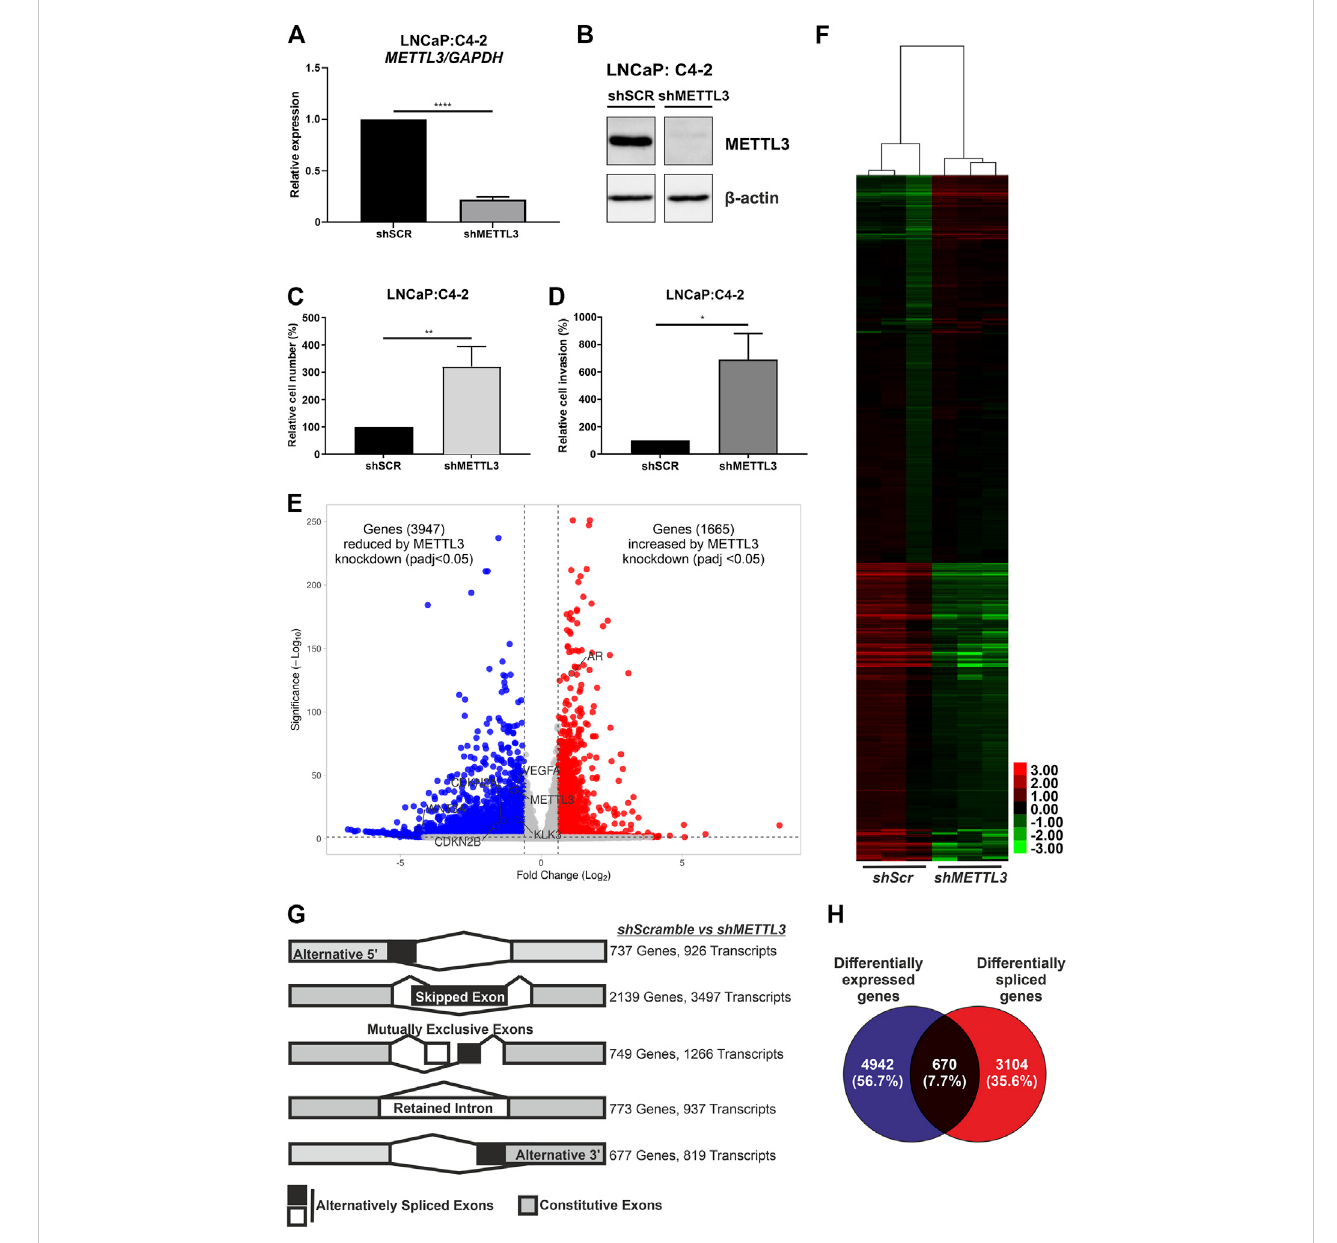
FIGURE 6 Inducible shRNA-mediated knockdown of METTL3 in LNCaP:C4-2 cells. Con fi rmation of METTL3 knockdown in LNCaP:C4-2 cells at the RNA (A) and protein (B) level. Cellular proliferation (C) and invasion (D) in sh METTL3 -treated LNCaP:C4-2 cells compared with shSCR scrambled controls. Distribution of differentially expressed genes between shSCR and sh METTL3 -treated LNCaP:C4-2 cells (E) . Heatmap of differentially expressed AR-regulated genes (F) . Differential alternative splicing determined by rMATS analysis. Transcripts refers to total number of transcripts observed, whereby multiple different transcriptscanbeobservedforasinglegene,andtheoverallnumberofgenesdifferentiallyspliced.Alternativesplicingeventsconsidered:alternative5 ′ splice site (A5SS), skipped exon (SE), mutually exclusive exons (MXE) and retained intron (RI) and alternative 3 ′ splice site (A3SS) (G) . Differentially expressed genes compared with differentially spliced genes (H) . ns, not signi fi cant; * p ≤ .05, ** p ≤ .005, **** p ≤ .0001 by unpaired t -test. DEG signi fi cant if fold change ≤ ±1.5 and adjusted p -value < .05 and splicing event signi fi cant if dPSI ≥ 5% and FDR <